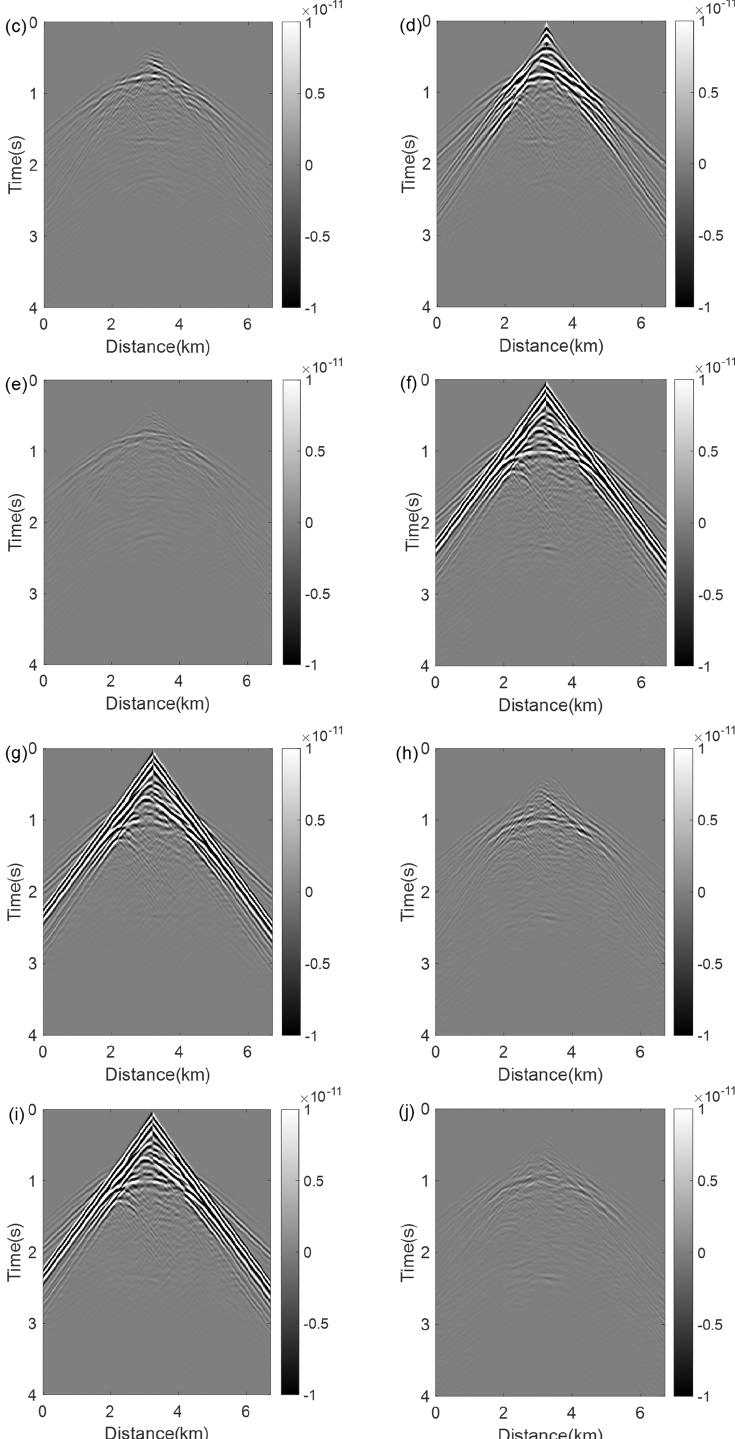
Figure 9. Data fitting results. ( a ) Z-component observed data; ( b ) Z-component synthetic data on Figure 6c,d; ( c ) Difference profile of Figure 9a,b; ( d ) Z-component synthetic data on Figure 6g,h; ( e ) Difference profile of Figure 9a,d; ( f ) X-component observed data; ( g ) X-component synthetic data on Figure 6c,d; ( h ) Difference profile of Figure 9f,g; ( i ) X-component synthetic data on Figure 6g,h; ( j ) Difference profile of Figure 9f,i.